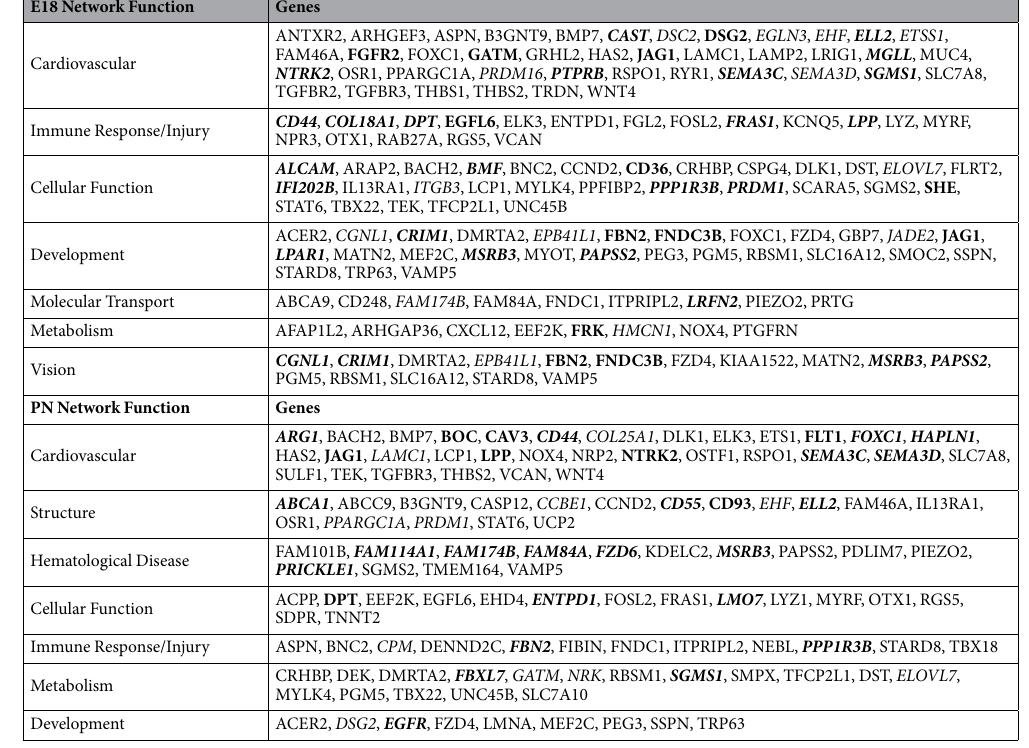
Table 2. Ingenuity pathway analysis (IPA) of miRNA, RORA and NR2E3 target genes. Genes regulated by NR2E3 are in bold; genes regulated by RORA are in italics, and genes regulated by NR2E3 and RORA are bold and